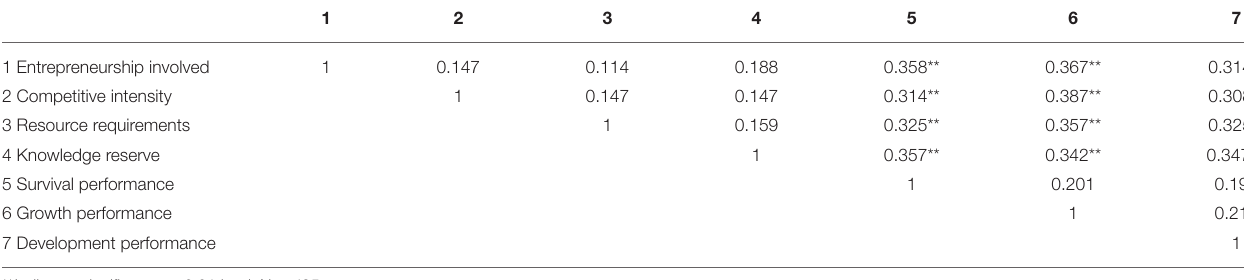
TABLE 10 | The correlation analysis of entrepreneurial stress and new venture performance of new venture entrepreneurs.